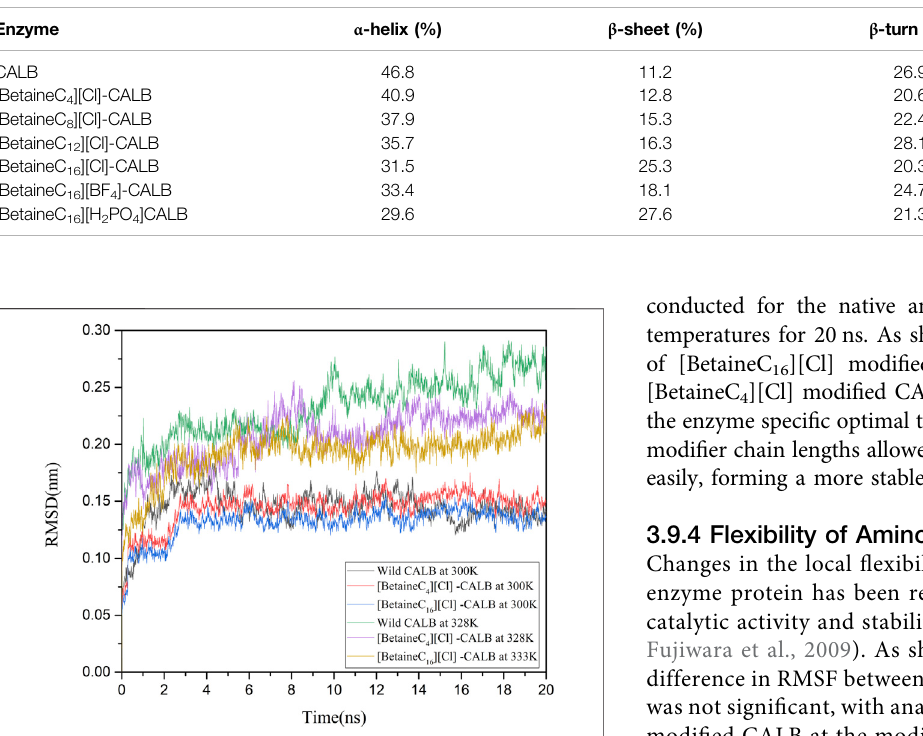
FIGURE 7 | Changes in the RMSD values of native and modi fi ed enzymes at 300 K and their respective optimal temperatures.